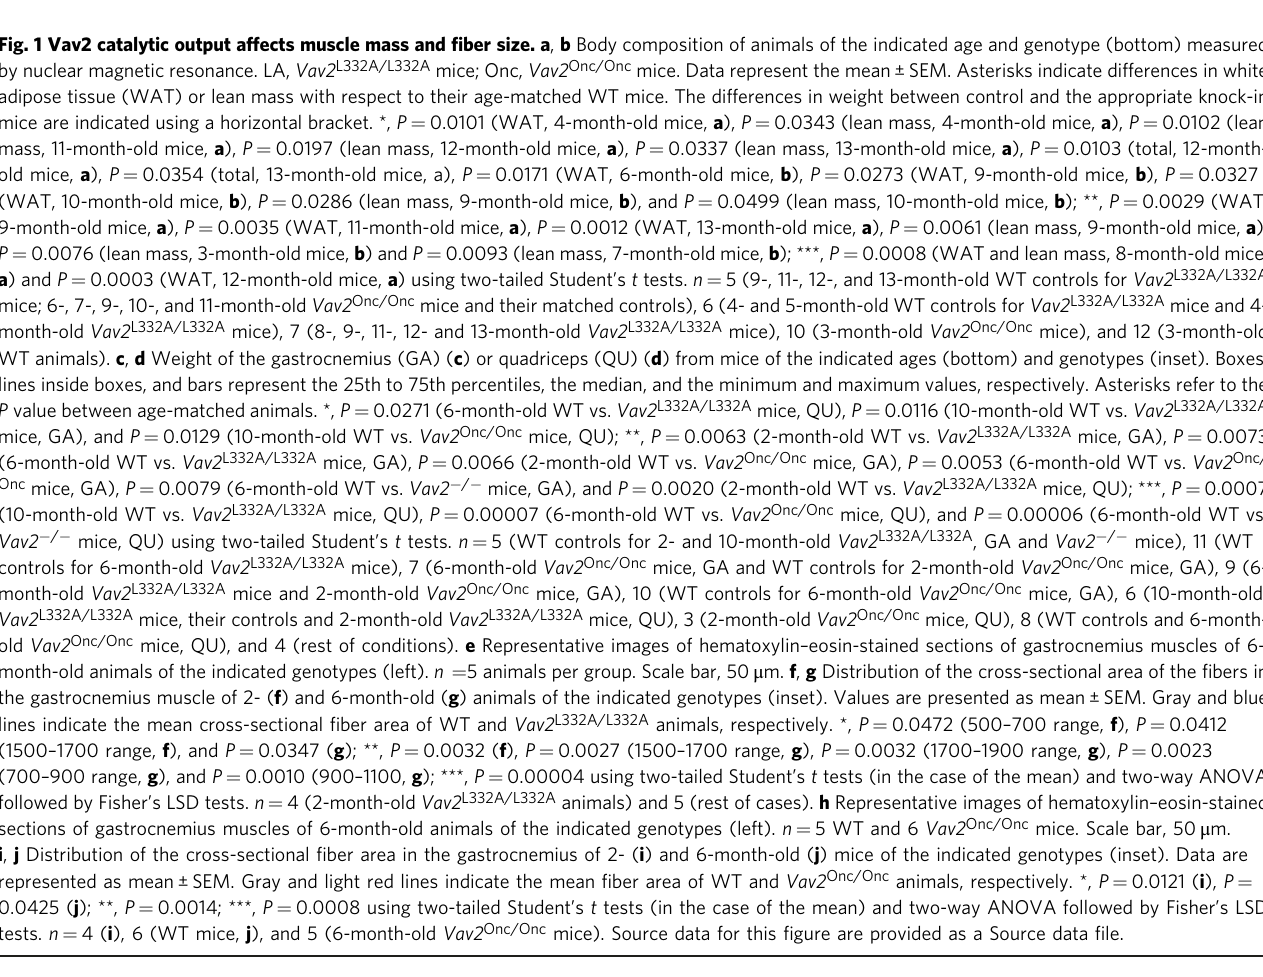
Fig. 1 Vav2 catalytic output affects muscle mass and fi ber size. a , b Body composition of animals of the indicated age and genotype (bottom) measured by nuclear magnetic resonance. LA, Vav2 L332A/L332A mice; Onc, Vav2 Onc/Onc mice. Data represent the mean ± SEM. Asterisks indicate differences in white adipose tissue (WAT) or lean mass with respect to their age-matched WT mice. The differences in weight between control and the appropriate knock-in mice are indicated using a horizontal bracket. *, P = 0.0101 (WAT, 4-month-old mice, a ), P = 0.0343 (lean mass, 4-month-old mice, a ), P = 0.0102 (lean mass, 11-month-old mice, a ), P = 0.0197 (lean mass, 12-month-old mice, a ), P = 0.0337 (lean mass, 13-month-old mice, a ), P = 0.0103 (total,